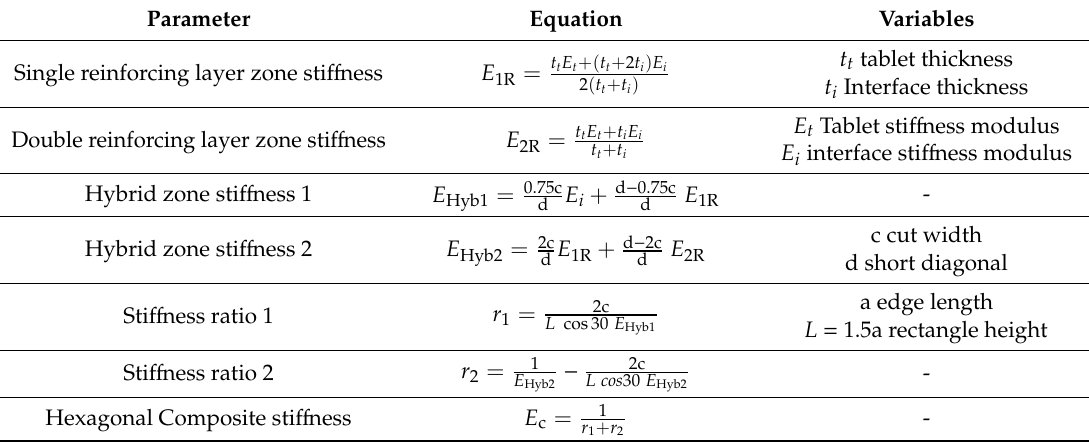
Table 3. Hexagonal Composite Sti ff ness